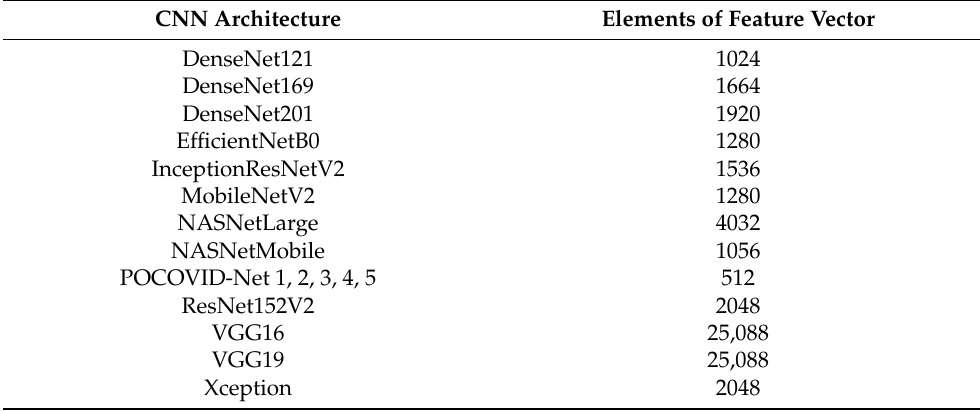
Table 5. Elements of feature